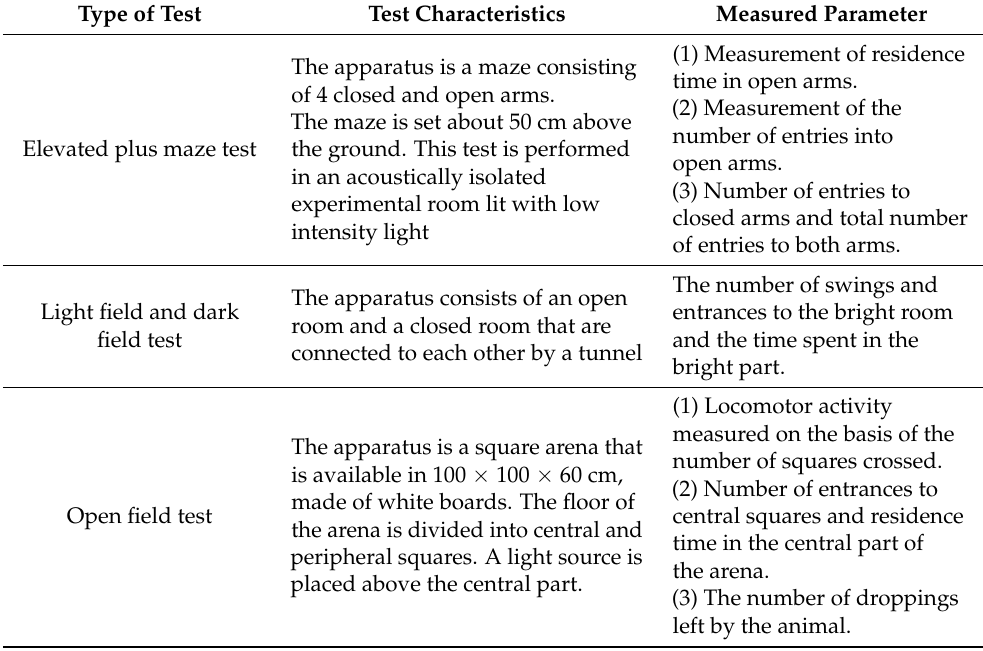
Table 2. Review of behavioral tests to assess anxiety-like